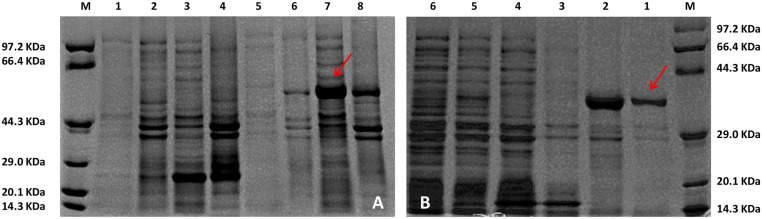
SDS-PAGE analysis of recombinant TwFPS1and TwFPS2 protein expressed in E. coli.
A Lane M, protein molecular weight marker(low); Lane 1, the supernatant of the empty vector without the induction; Lane2, the sediment of the empty vector without the induction; Lane 3, the supernatant of the empty vector with the induction; Lane 4, the sediment of the empty vector with the induction; Lane 5, the supernatant of theTwFPS1 protein without the induction; Lane 6, the sediment of the TwFPS1 protein without the induction; Lane7, the supernatant of theTwFPS1 protein with the induction; Lane 8, the sediment of TwFPS1 protein with the induction; B Lane M, protein molecular weight marker (low); Lane 1, the supernatant of theTwFPS2protein with the induction; Lane 2,the supernatant of the empty vector bacteria with the induction; Lane 3,the supernatant of theTwFPS2 bacteria with the induction; Lane 4, the sediment of the empty vector with the induction; Lane 5, the supernatant of the empty vector with the induction; Lane 6, the sediment of TwFPS2 protein with the induction.